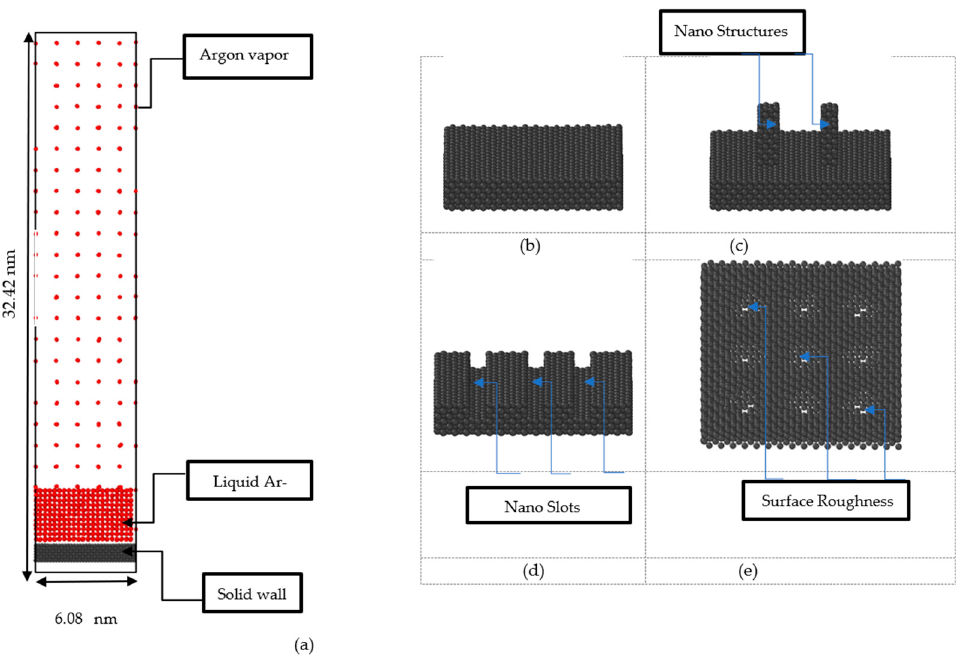
Figure 1. Simulation domain and solid wall configuration: ( a ) initial simulation domain for smooth surface. Different surface texture: ( b ) smooth surface, ( c ) surface with nano structures, ( d ) surface with nano slots, ( e ) surface with nano level roughness (to make the figure ( e ) clear, we changed the viewing angle and the radius of the particles).